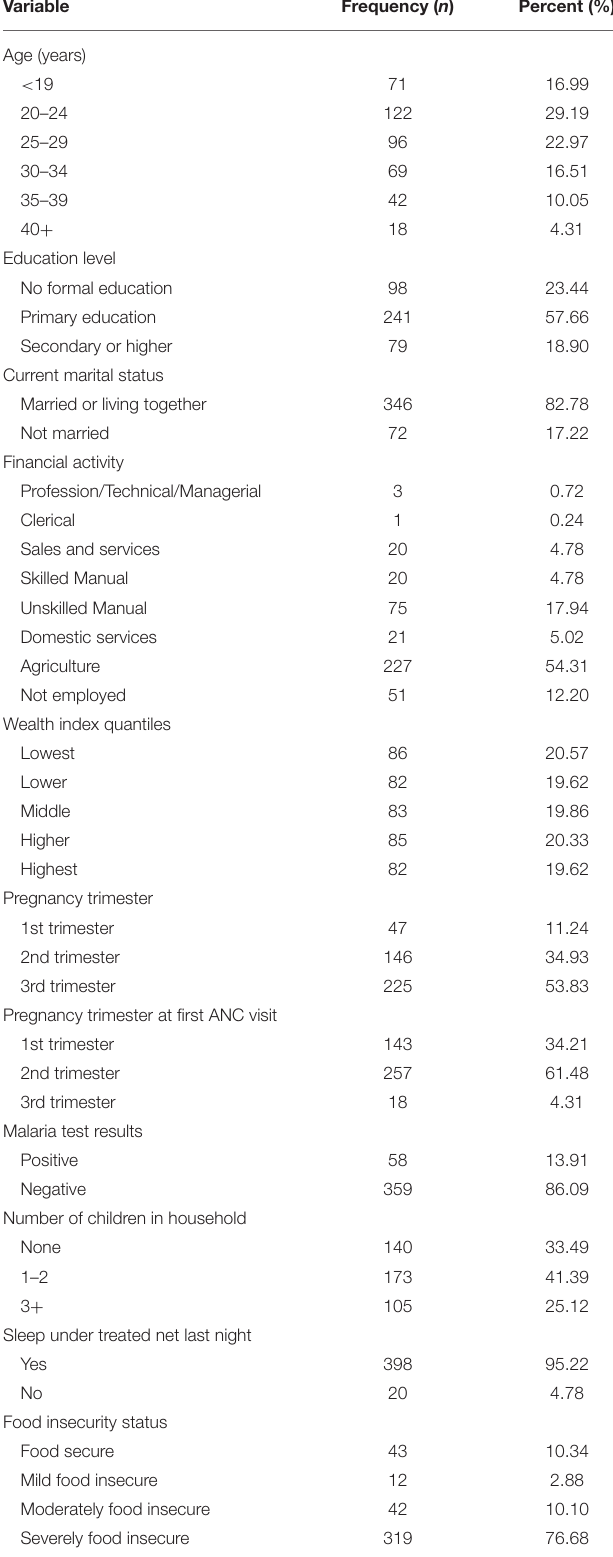
TABLE 1 | The background characteristics of the pregnant women under the